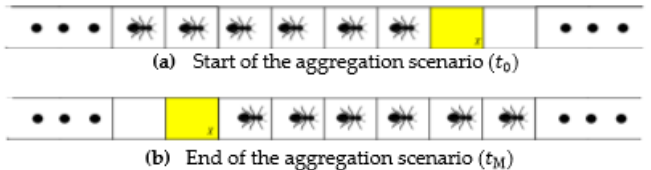
Figure 4. Schematic representation of ( a ) start of aggregation scenario ( time = t 0 ), and ( b ) end of aggregation scenario ( time = t M ). In this scenario, we consider the cell X (yellow cell), through which a considerable length of platoon will pass, leading to the aggregation of pheromone in that cell [29,30].